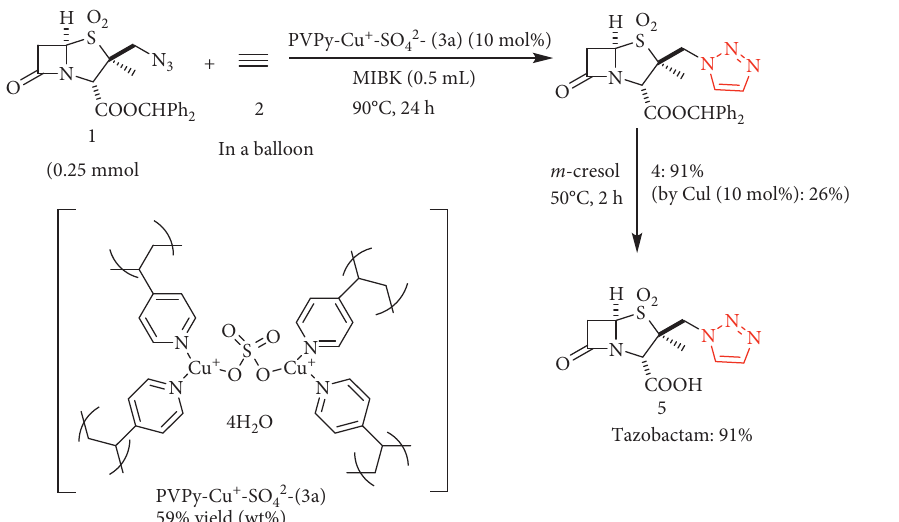
Scheme 10: Synthesis of